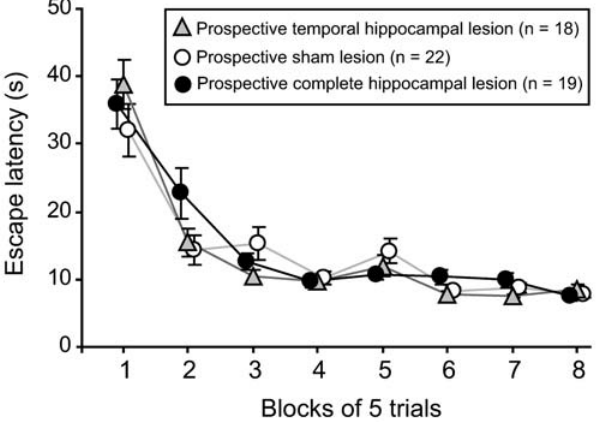
Mean latencies to escape from the water and climb onto the hidden platform during task acquisition. Data are averaged in blocks of five trials and grouped according to the lesion made at the end of training; note that all animals were unoperated during acquisition. Only rats that reached criterion (mean escape latency less than 15 s over the last ten trials) and whose lesions were considered acceptable (see Results: Surgery) are presented. Animals rapidly learned to locate the escape platform, and prospective lesion groups did not differ. DOI: